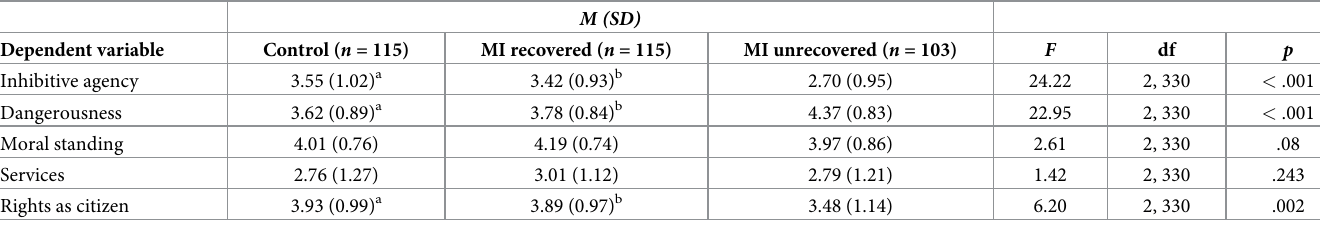
Table 6. Descriptive and inferential statistics for dependent variables after release (Study 2).